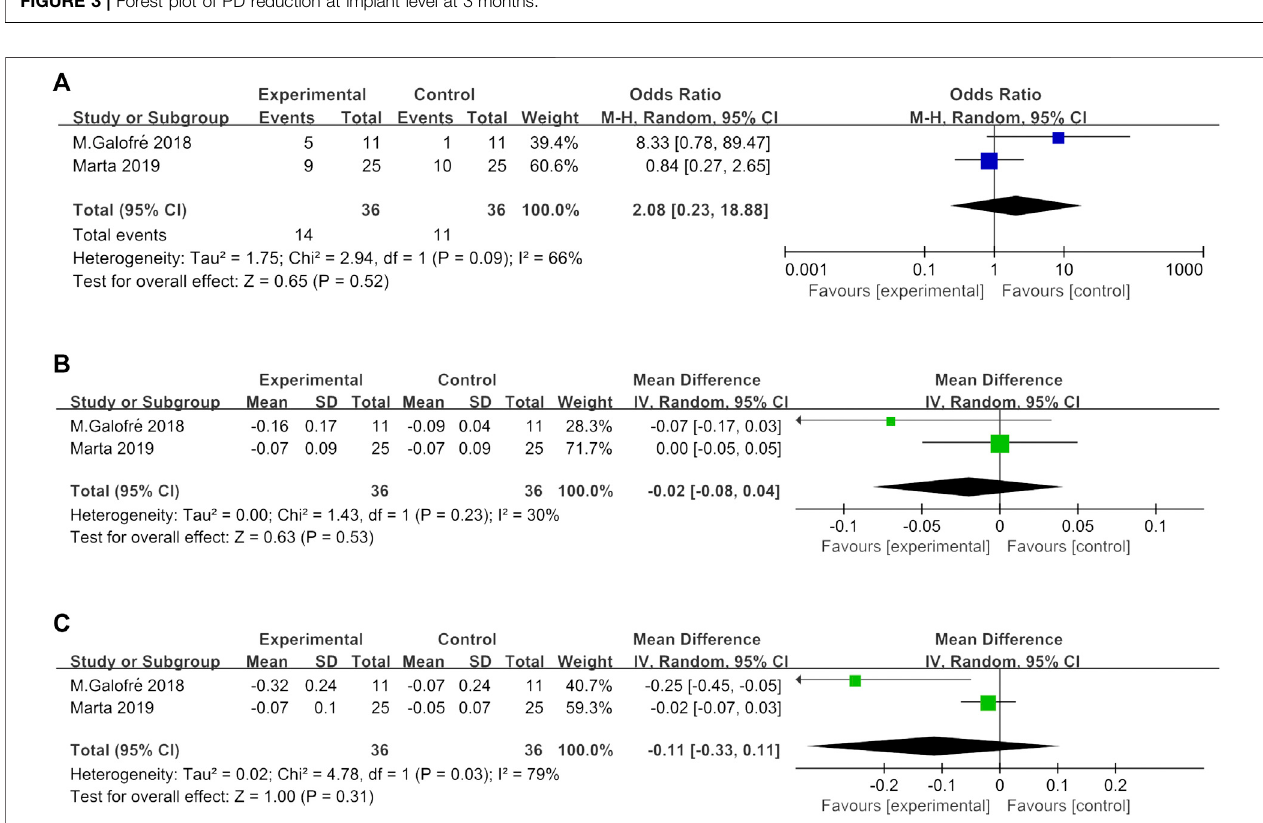
FIGURE 4 | (A) Forest plot of BOP absence at implant level at 3 months. (B) Forest plot of the overall FMPI reduction at 3 months. (C) Forest plot of the overall FMBOP reduction at 3 months.